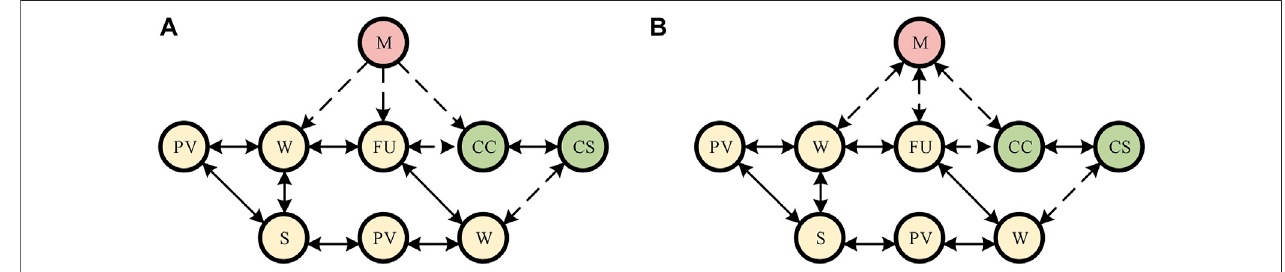
FIGURE 3 | The topology of low carbon port microgrid based on polymorphic network. (A) is the topology of the information fl ow, (B) is the topology of the energy fl